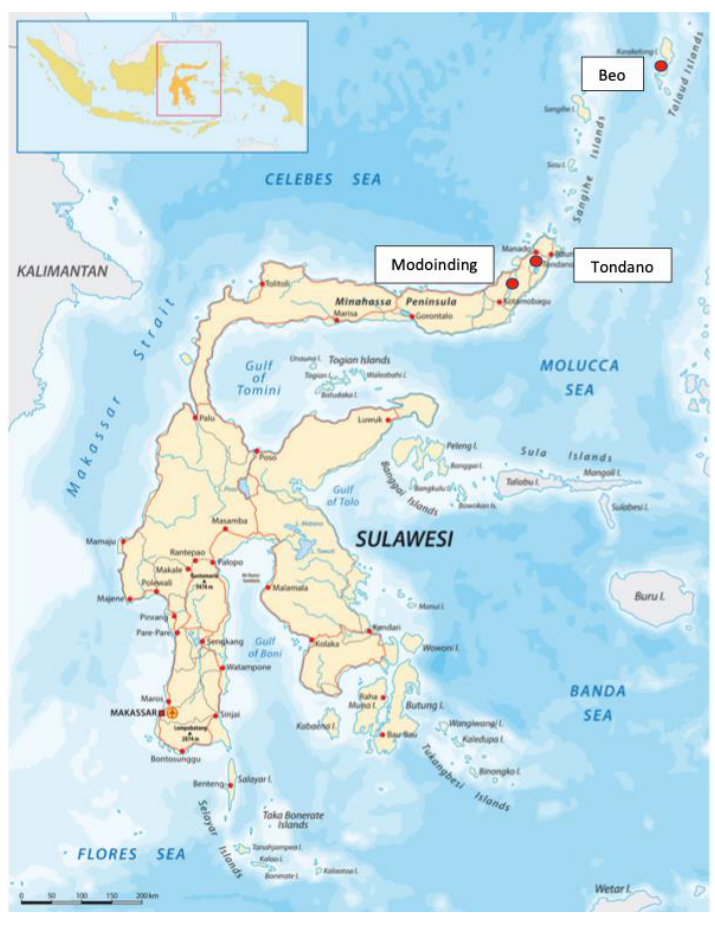
Figure 1. Map of Sulawesi indicating the source of cases in North Sulawesi.